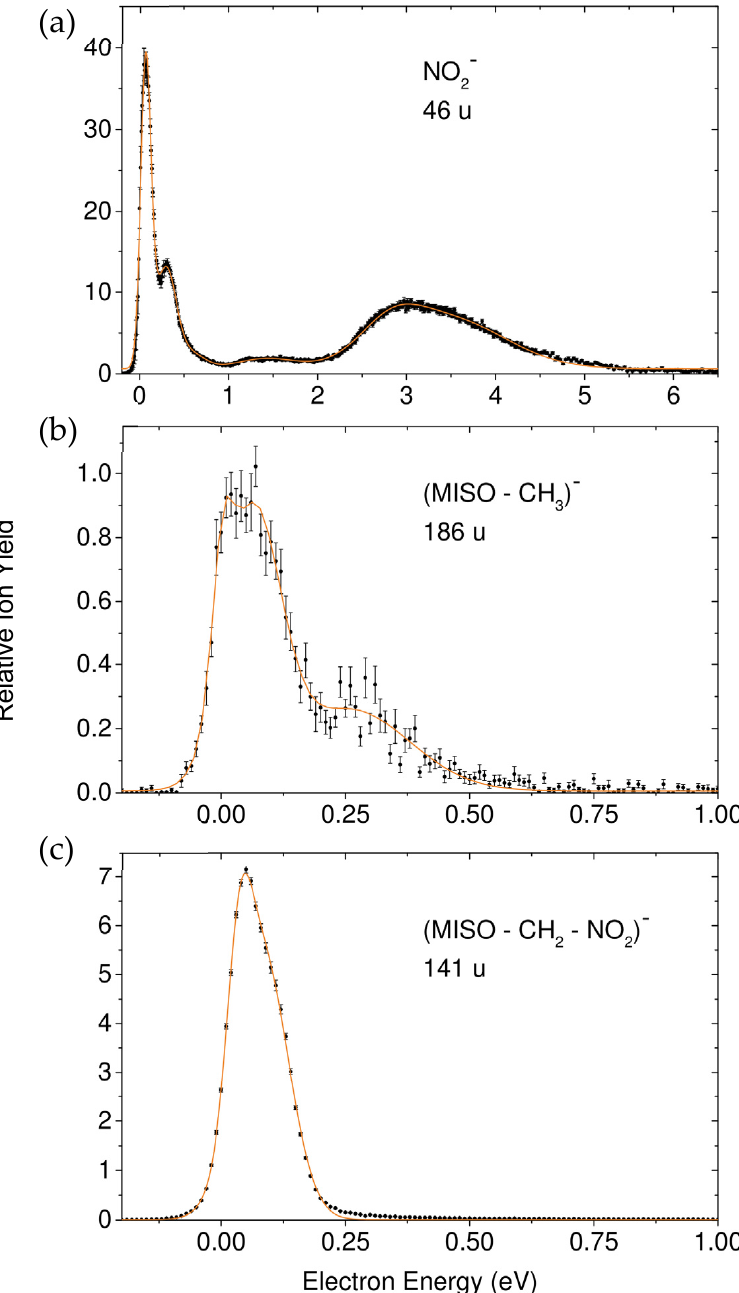
Figure 3. Relative ion yields for the dissociative electron attachment (DEA) reactions generating the NO 2 − fragment ion ( a ), the fragment ion arising from the loss of a neutral CH 3 unit (M – CH 3 ) − ( b ), and the fragment ion due to the loss of the two neutral units CH 2 and NO 2 (M – CH 2 – NO 2 ) − ( c